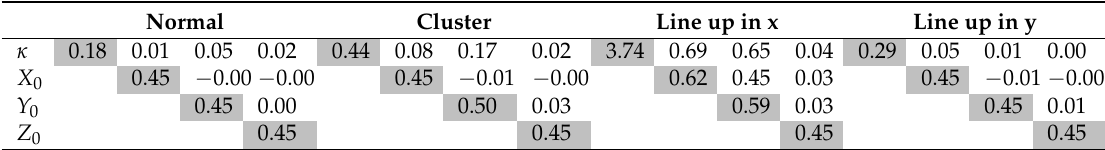
of 2-feature simulated P ˆ P